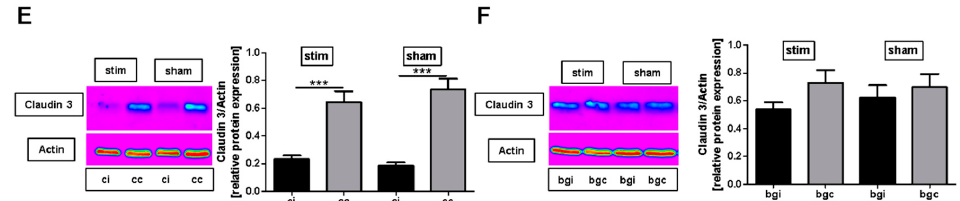
Figure 2. Stimulation of the mesencephalic locomotor region does not modulate photothrombosis-driven tight junction protein degradation. ( A , B) , Representative anti-occludin Western blot analysis (cc, cortex contralesional; ci, cortex ipsilesional; bgc, basal ganglia contralesional; bgi, basal ganglia ipsilesional) and densitometric quantification of occludin protein expression in the basal ganglial as well as cortical regions 27 h after photothrombosis of unstimulated (sham) and high-frequency stimulated (stim) rats ( n = 5 – 7/group). One-way ANOVA. * p < 0.05; ** p < 0.01. ( C , D ), Representative anti-claudin 5 Western blot analysis (cc, cortex contralesional; ci, cortex ipsilesional; bgc, basal ganglia contralesional; bgi, basal ganglia ipsilesional; bd, beyond detection limit) and densitometric quantification of claudin 5 protein expression in the basal ganglial as well as cortical regions 27 h after photothrombosis within the two treatment groups ( n = 5–7 / group). One-way ANOVA. ( E , F ), Representative anti-claudin 3 Western blot analysis (cc, cortex contralesional; ci, cortex ipsilesional; bgc, basal ganglia contralesional; bgi, basal ganglia ipsilesional; bd, beyond detection limit) and densitometric quantification of claudin 3 protein expression in the basal ganglial as well as cortical regions 27 h after photothrombosis within the